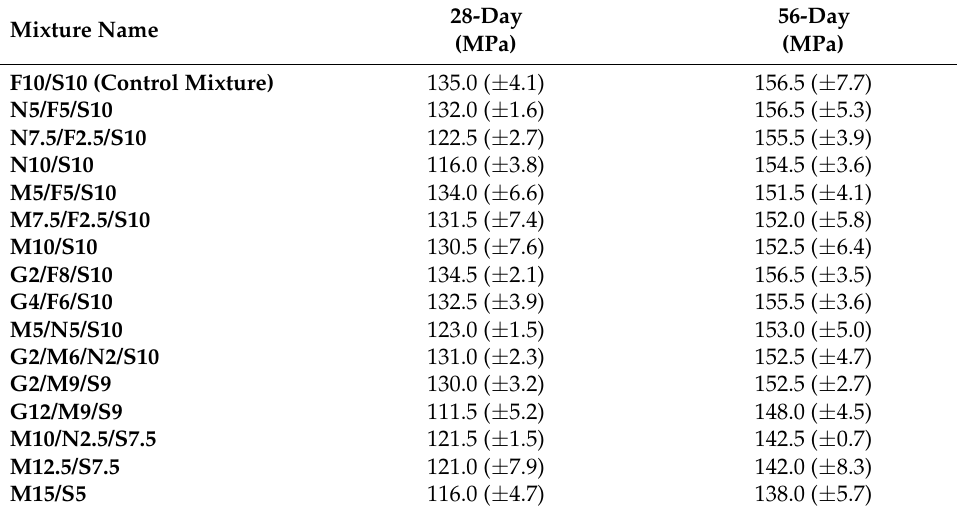
Table 3. Compressive strength results ( ± standard